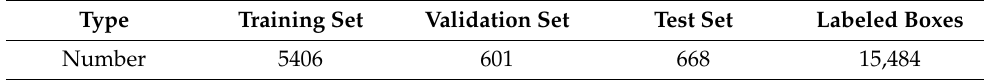
Table 1. Experimental dataset partition.